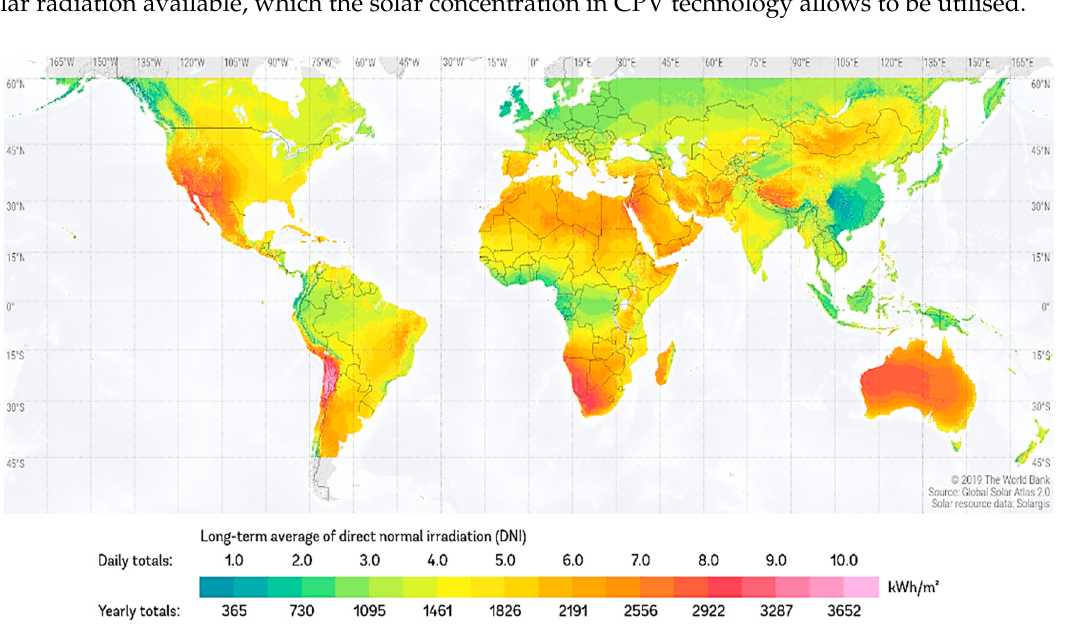
Figure 1. Direct Normal Irradiance in the world [39].